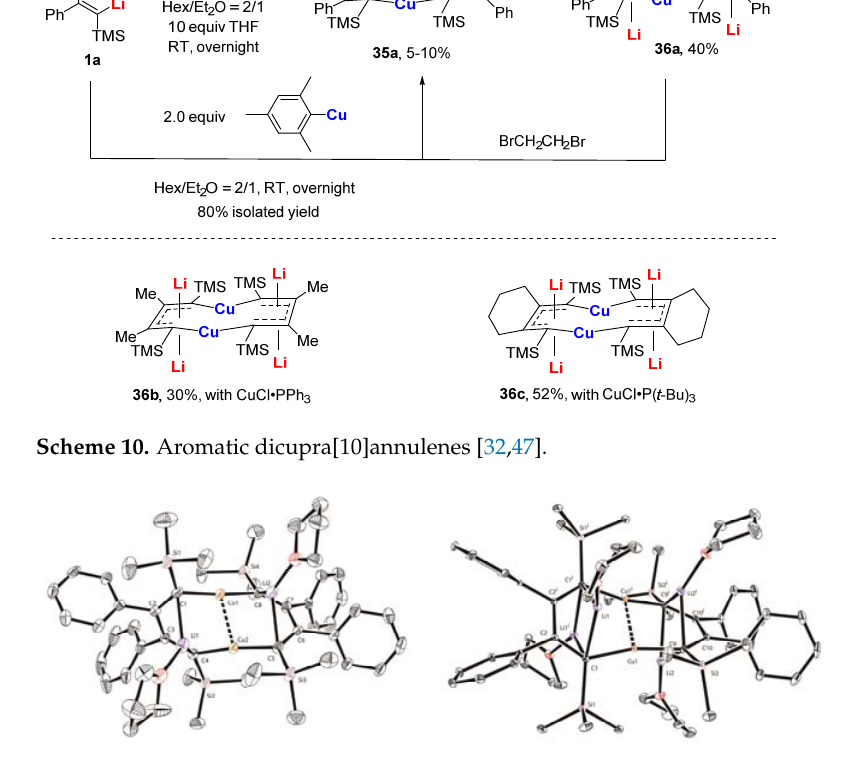
Figure 5. Molecular structures of 35a and 36a . Modified with permission from [32]. Copyright 2016 American Chemical Society.